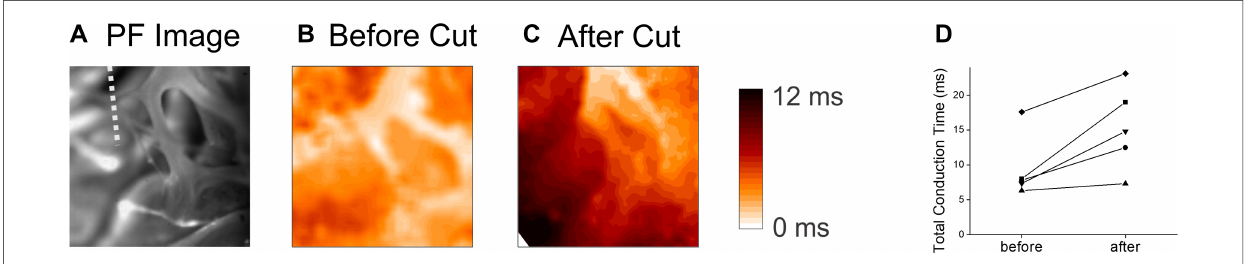
FIGURE 6 Endocardial activation time before and after cutting the free-running purkinje fi bers. ( A ) Image of the PF network on the RV apex. The white dotted line indicates the location of cut. ( B ) Activation map before the cut. The activation of the endocardium in the fi eld of view (4 mm×4 mm) occurred within a short period of time ( Supplementary Movie S8 ). ( C ) Activation map after cutting a PF branch indicated in panel B . After cutting, the activation pattern changed to a simpler unidirectional propagation ( Supplementary Movie S9 ). ( D ) Summary of total activation time in the fi eld of view (4 mm×4 mm) before and after cutting a major PF branch. E,F panels are associated with the activation maps before and after the PF cut, respectively.